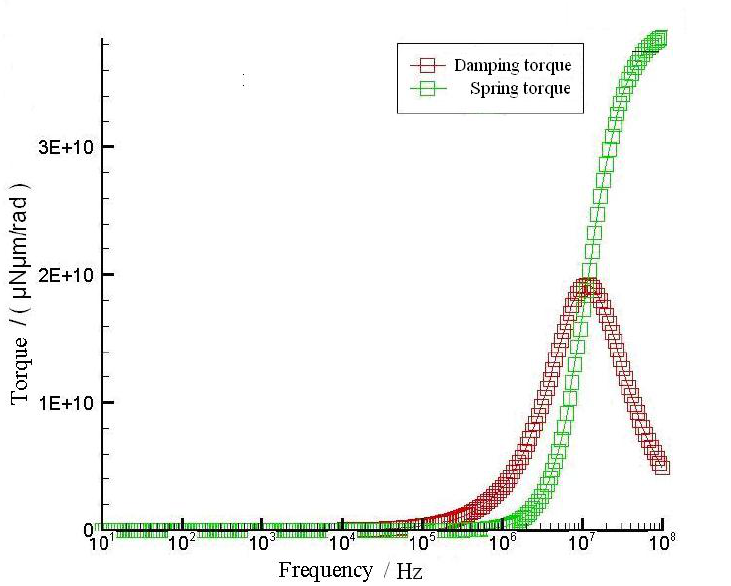
Figure 12. Frequency characteristics of the damping torque and spring